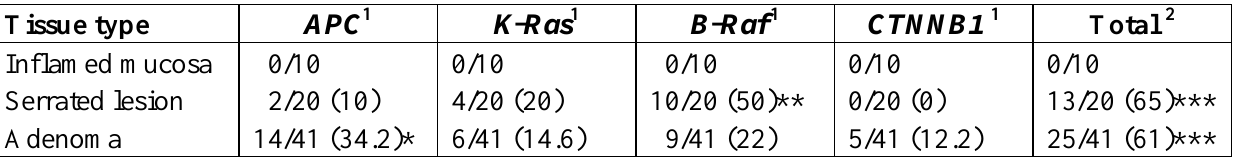
Table 2. Gene mutation frequency in the colorectal lesions analyzed.